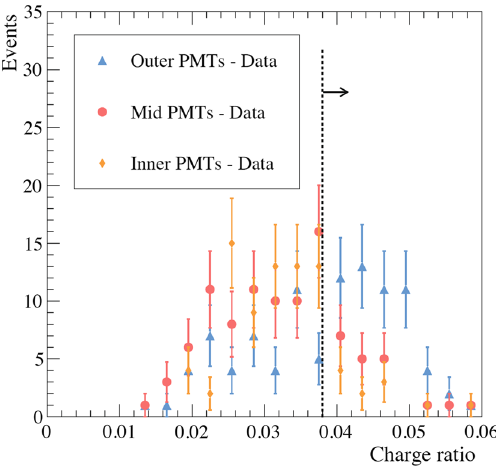
Fig. 11 Ratio of charge in a prompt, 5 ns window to the total charge for each hit PMT for